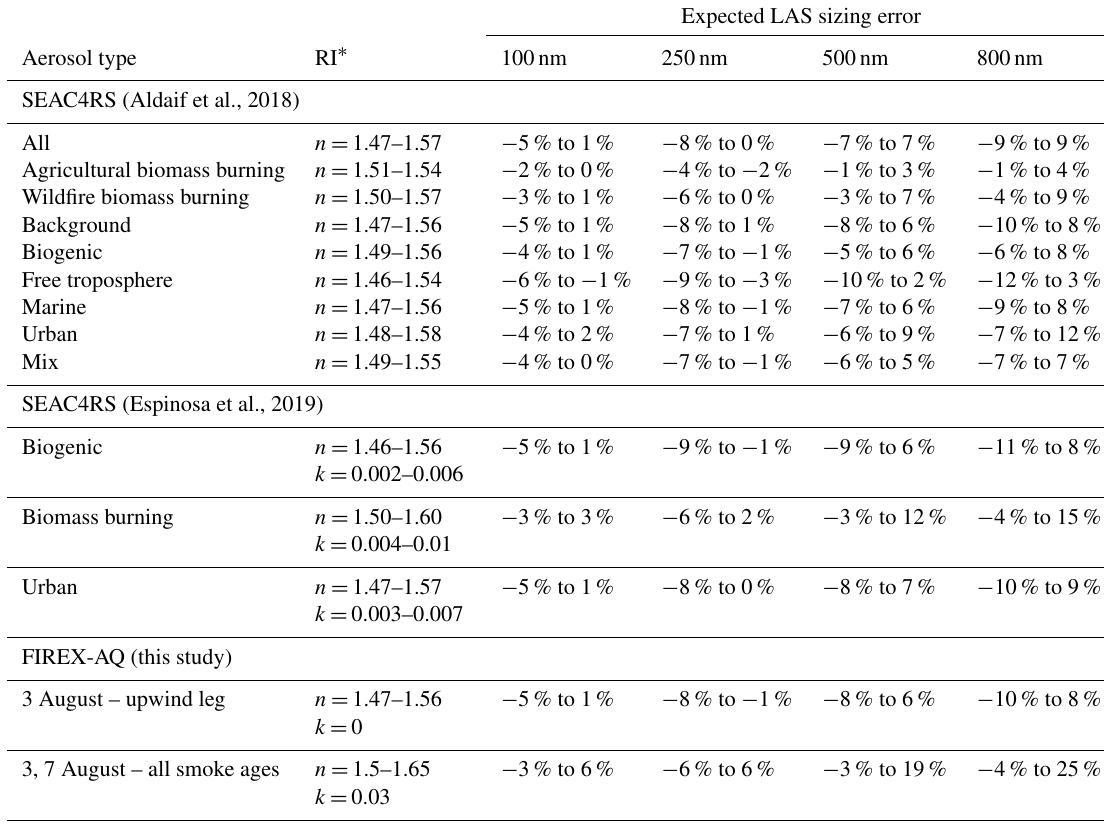
Table 2. Expected percent LAS sizing error associated with an atmospherically relevant range of refractive indices (RIs) computed for each size by linearly interpolating between the laboratory response curves of NaF, (NH 4 ) 2 SO 4 , NaCl, and SRFA, as shown in Figs. 5 and